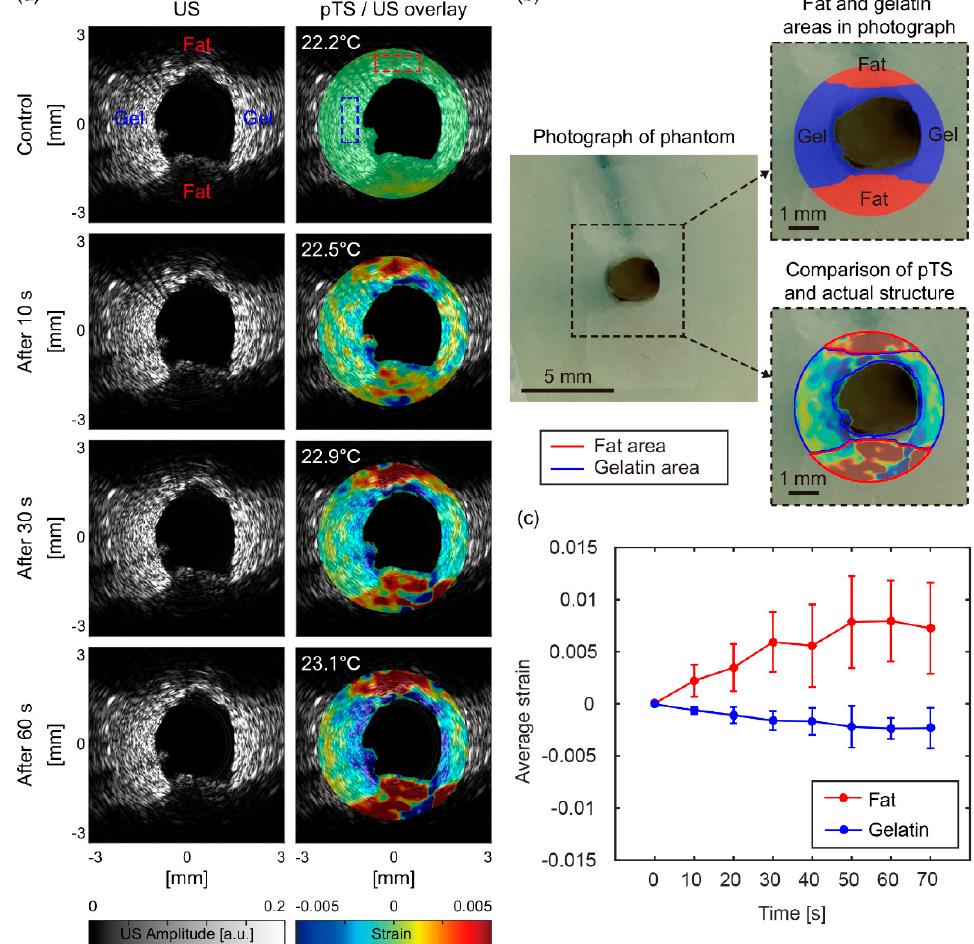
Figure 4. ( a ) Ultrasound images (1st column) and photothermal strain/ultrasound overlay images (2nd column) of the phantom at the time increased. ( b ) A photograph of phantom, an actual structural image of fat and gelatin areas, and a comparison image of the pTS image (at 60 s) and the actual structure image. ( c ) A graph of average strain change in fat (red dotted box in Figure 4a) and gelatin (blue dotted box in Figure 4a) over time. Gel, gelatin; US, ultrasound; pTS, photothermal strain.